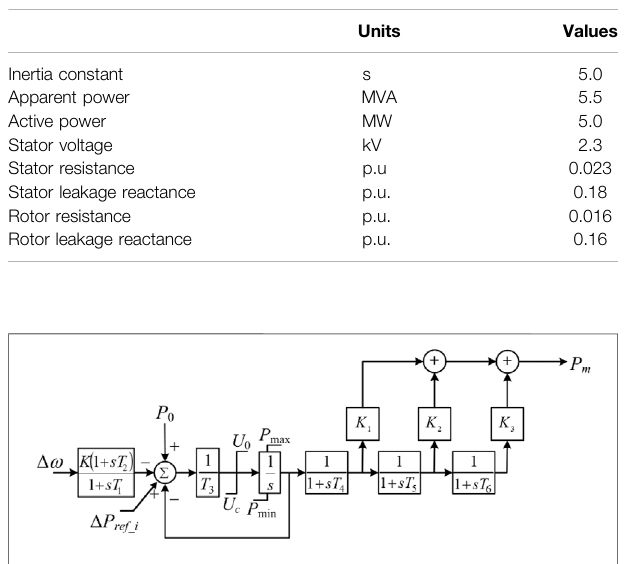
TABLE 1 | Parameters of the DFIG.